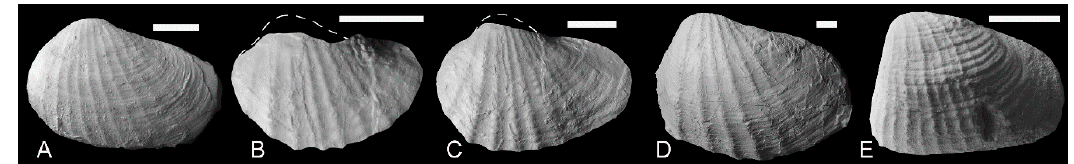
Figure 12. Shapes of anteriors of various Pholadomya . ( A ), Ph. latirostris (Rudniki near Zawiercie, Lower Bathonian, Institute of Paleobiology of Polish Academy of Sciences collection, specimen ZPAL Mo.XII-38)—rounded anterior, traditionally referred to as subgenus Pholadomya s.str. ( B – D ), Ph. lirata (Upper Bathonian, Cz ę stochowa, specimen MGUS.Sz.3587)—changes of shape during growth of one individual, species of subgenus Bucardiomya . ( E ), Ph. acuminata (Wysoka, Middle Oxfordian, specimen MGUS.Sz.3584, right valve, reversed)—flat front, subgenus Procardia .